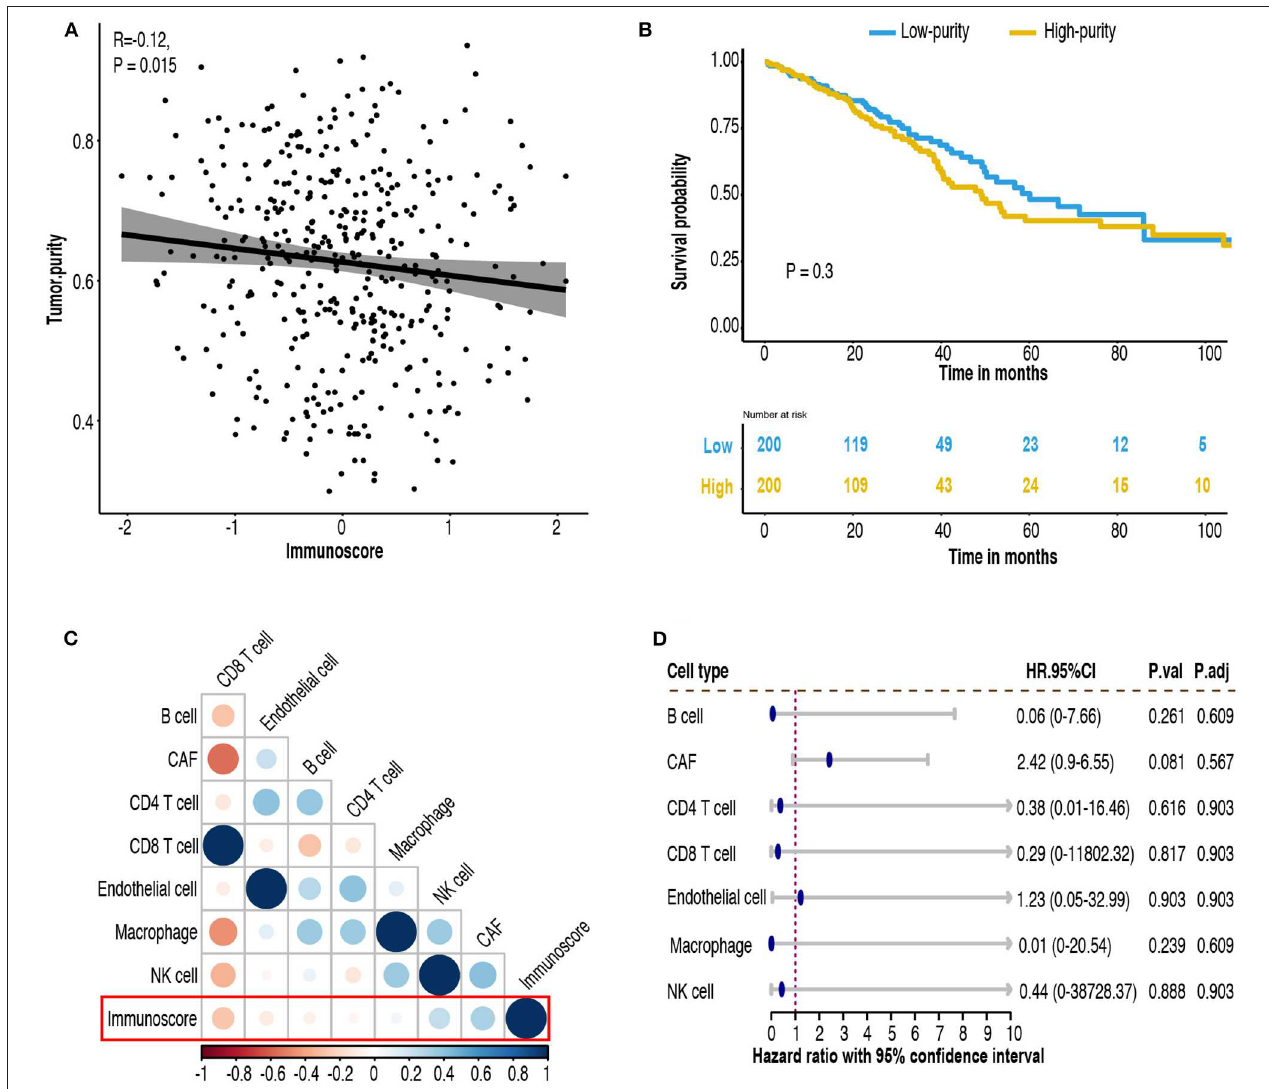
FIGURE 10 | Tumor microenvironment (TME) change associated with immunoscore. (A) Correlation between immunoscore and tumor purity. (B) Kaplan-Meier curves of patient survival according to tumor purity in the TCGA-LUAD cohort. (C) Correlation matrix of immunoscore and cell proportions. (D) Univariate Cox analysis of various cell type. HR.95%CI, hazard ratio with 95% confidence interval. P.adj, adjusted P -value by false discovery rate.